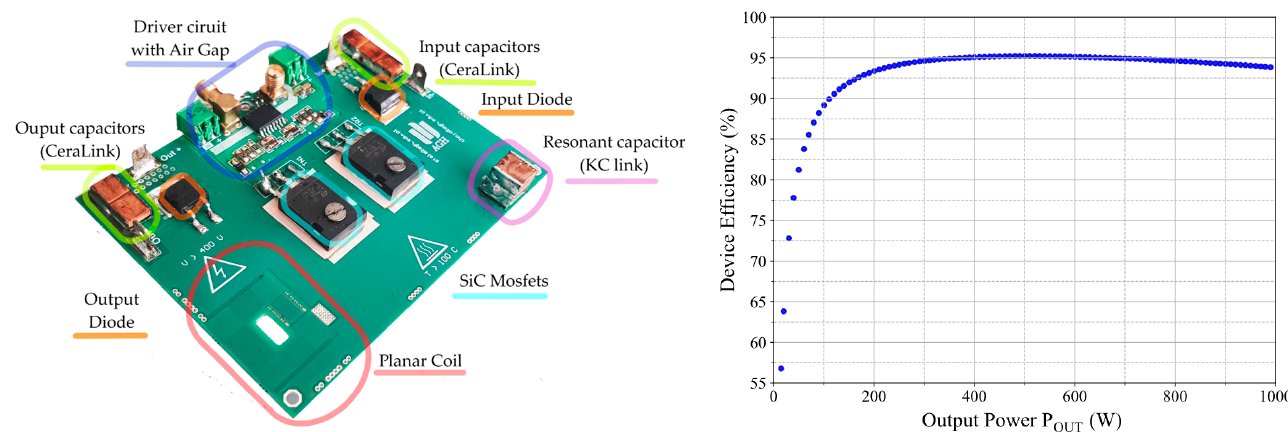
Figure 5. Power module and experimental results of efficiency versus output power for 50% of duty cycle and fixed frequency f SW . Table 2. Parameters of the experimental setup and its implementation.